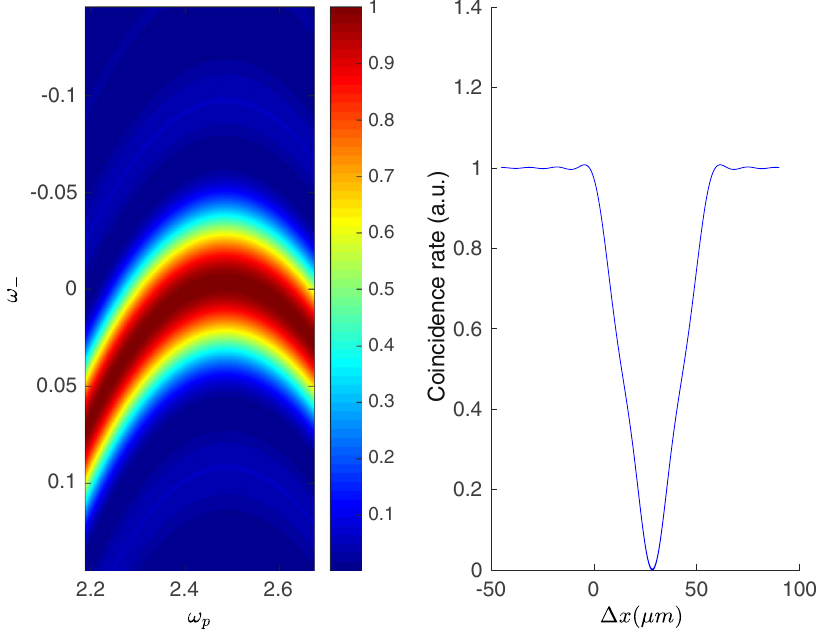
Figure 2. Left: the phase matching function φ 2 , as a function of ω p = ω 1 + ω 2 , and ω _ = ω 1 − ω 2 for collinear Type II. Right: HOM coincidence pattern as a function of the delay Δ x = c τ . The count rate is normalised so to be 1 in the absence of interference, for long delays. Both panels refer to the case for a 2-mm β − barium borate (BBO) crystal, phase matched for 775 nm → 1550 nm